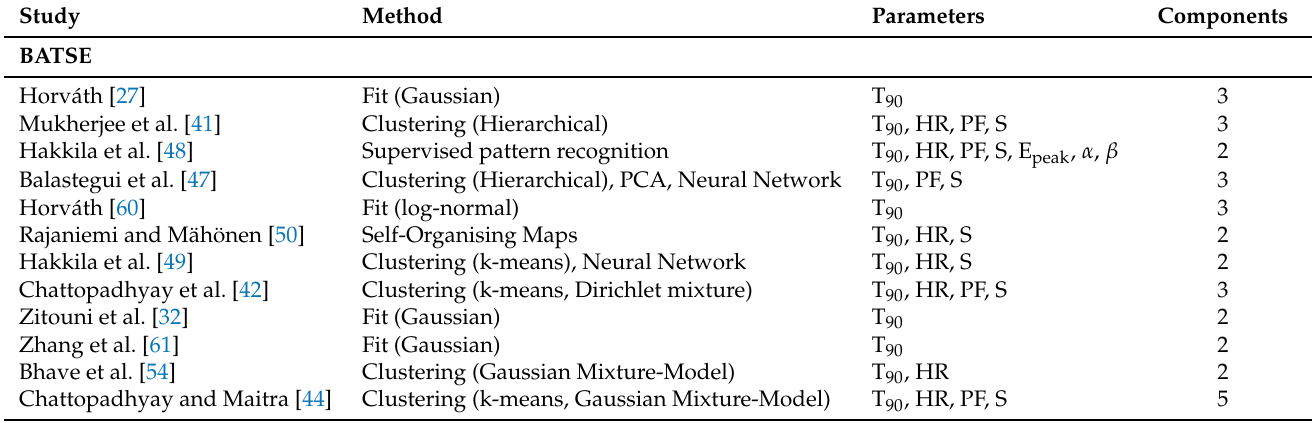
Table 1. Methods and resulting components identified in clustering, fitting, and dimensionality reduction techniques applied to GRB populations. HR denotes Hardness Ratio, PF denotes Peak Flux, and S represents fluence. Studies which consider intrinsic properties such as redshift-corrected duration and hardness are marked with a